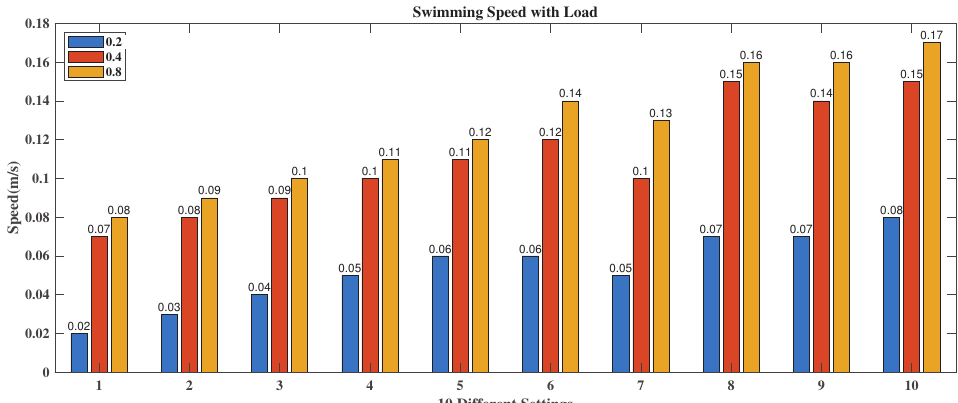
Figure 17. Swimming speed with loads.